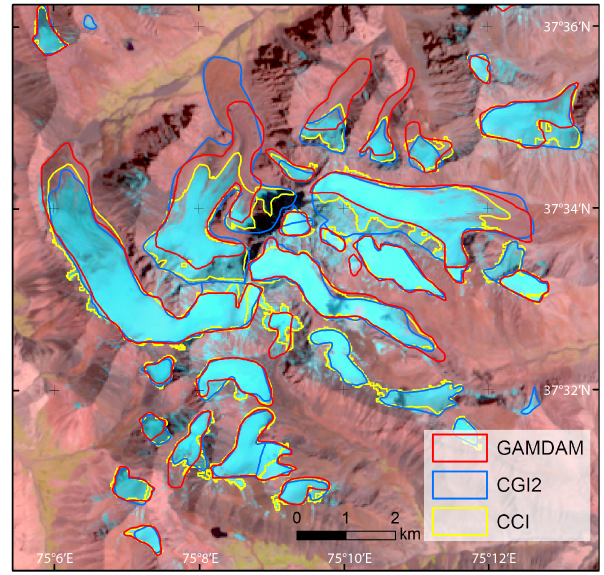
Figure 15. Comparison example of the three